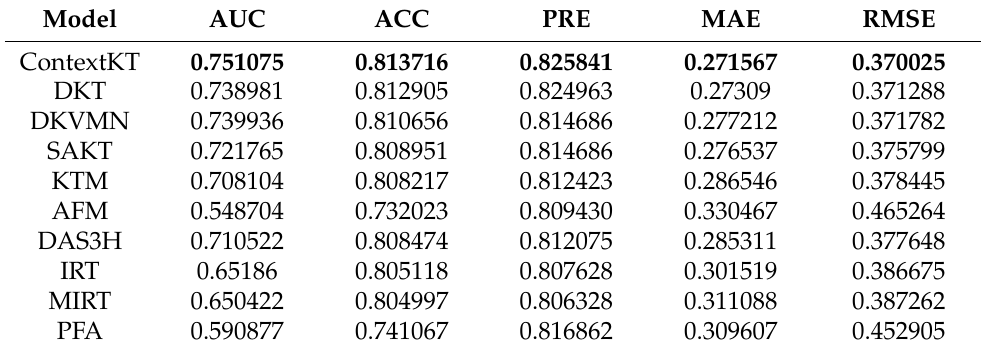
Table 6. Performance Comparison of Methods on Algebra08